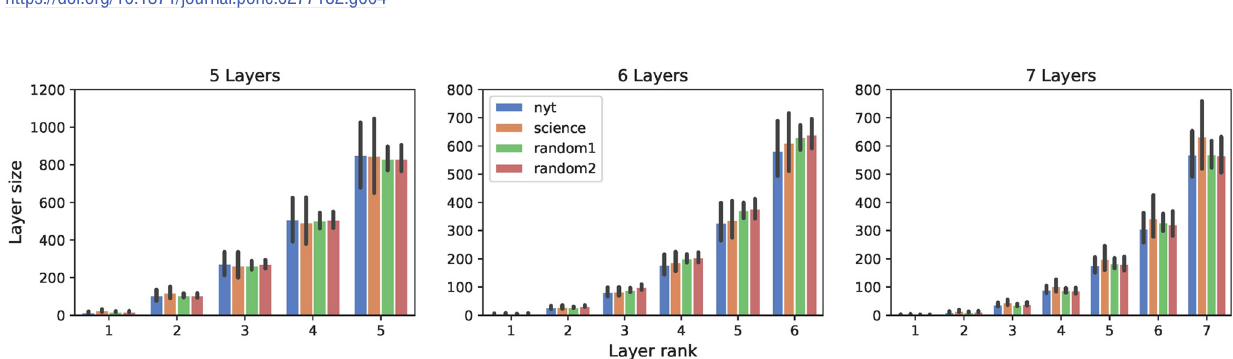
Fig 5. Average layer size. Each panel captures egos with a different optimal number of clusters. Error bars correspond to the 95% confidence intervals.